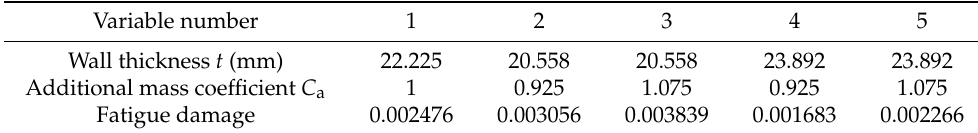
Table 4. Data for the response surface model of